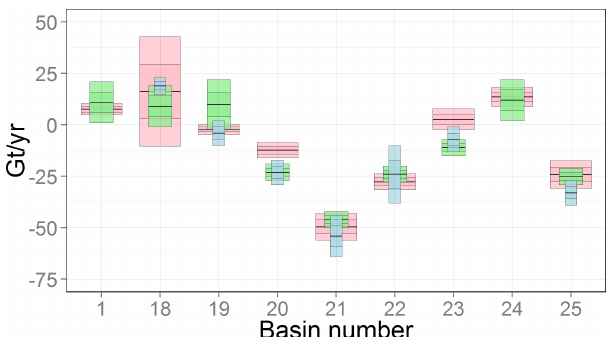
Figure 8. Combined Ice and SMB loss trends for West Antarctica using RATES (pink), results from King et al. (2013) (blue), and results from Sasgen et al. (2013) (green). Basin definitions for King et al. (2012) differ for basins 1 and 24, so they are given in Table 3 instead. Our basin 25 is equal to the sum of basins 25 and 26 in King et al. (2012); this is given here as basin 25 for the King estimate.